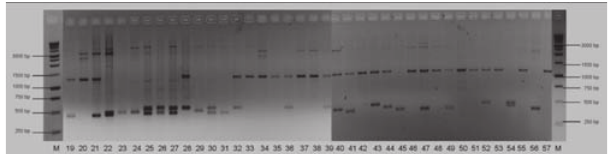
Figure 2. S-PCR analysis of 39 Turkish almond accessions from Akdamar Island, Turkey, conducted using the EMPC2-consFD and EMPC3-consRD. M: 1kb marker (Promega), 19-57: almond accessions.